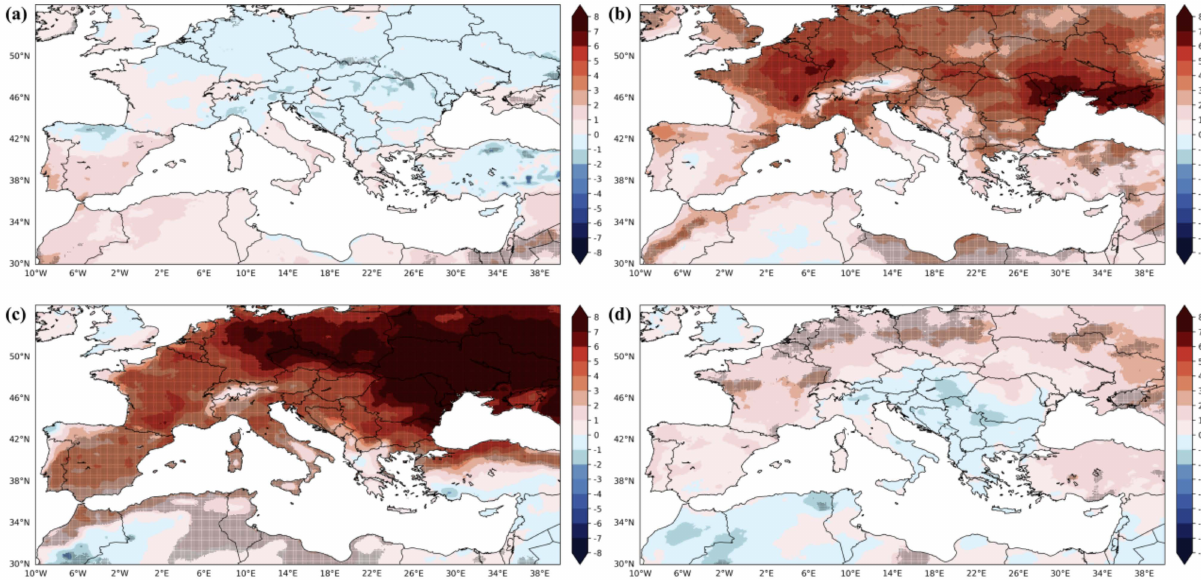
Figure 12. Seasonal SWGI trends (W/m 2 per decade) for the period 1981–2020 from ERA5-Land for ( a ) winter (DJF); ( b ) spring (MAM); ( c ) summer (JJA); and ( d ) autumn (SON). Dots indicate significant trends at the 95% level. The seasonal trends are expressed as anomalies from the 1981–2020